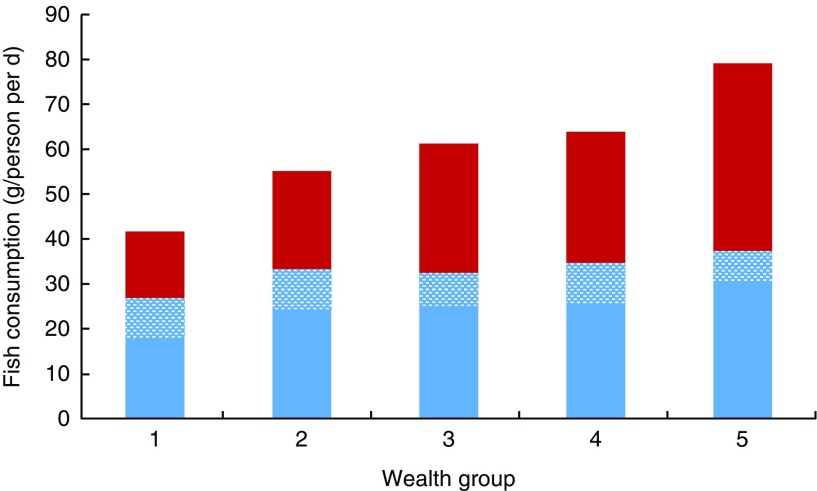
(colour online) Mean consumption (g/person per d) of non-farmed (,
non-farmed fresh fish; , non-farmed dried fish*) and farmed fish
() by wealth group† in rural Bangladesh
(adjusted for age, sex and geographic region), October 2011–March 2012. *Dried fish
includes fermented and dried fish, adjusted to fresh weight equivalent. The sum of
non-farmed fresh fish and non-farmed dried fish equals total non-farmed fish
consumption. †Wealth group 1 represents the poorest 20 % of households and wealth
group 5 represents the wealthiest 20 % of households